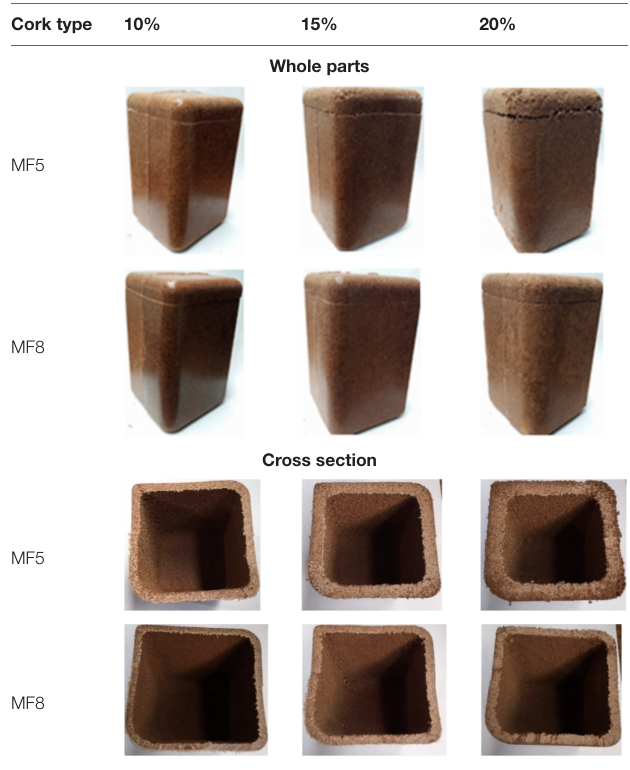
TABLE 2 | Images of parts produced by MDPE with different compositions of MF5 and MF8